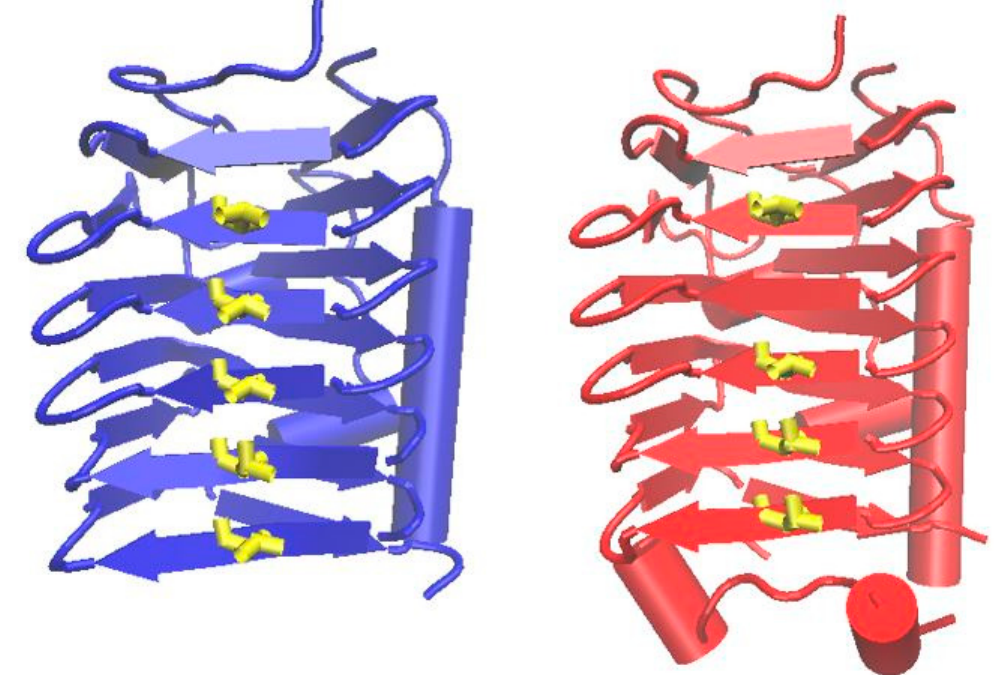
Figure 4. Cartoon representation of ice-binding motif models of Svilae_00062 (blue) and Svilae_00202 (red). The putative ice-binding surface with ordered threonine residues (yellow), is shown. Arrows and ribbons represent β -strands and α -helices, respectively.